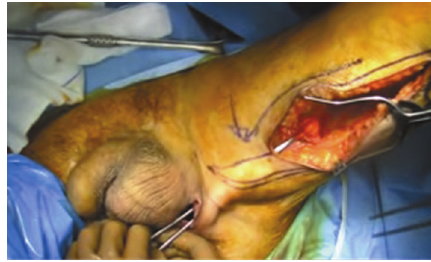
Figure 7: Gracilis flap tunneled.